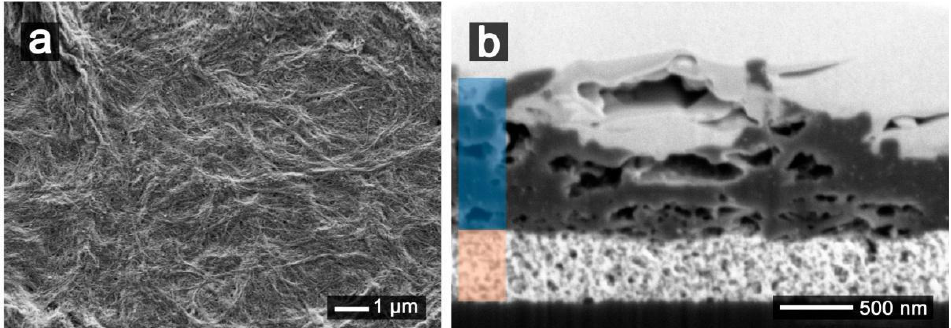
Figure 5. 2-layer Au WE printed with 12-layer of 7.5 mg/mL of SWCNT ( a ) SEM image of the top view of its surface and ( b ) the corresponding cross section. Au layers are shaded in orange and the SWCNTs ones are shaded in blue.